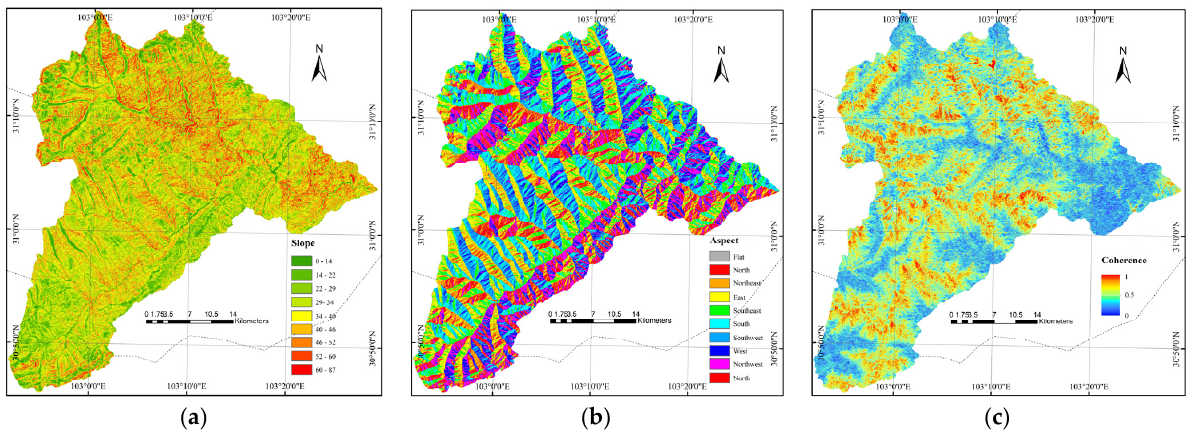
Figure 9. The slope map ( a ) aspect map ( b ) and coherence coefficient map ( c ) of study area. However, the results of the phase center height established by the coherence amplitude method have the same distribution trend as the actual tree height line graph